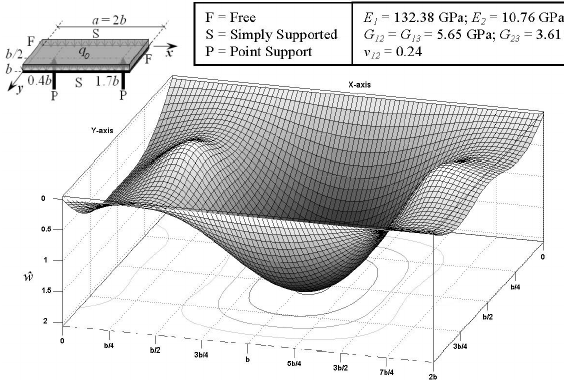
(︁ 100 E )︁ 2 h 3 w versus ply b 4 q